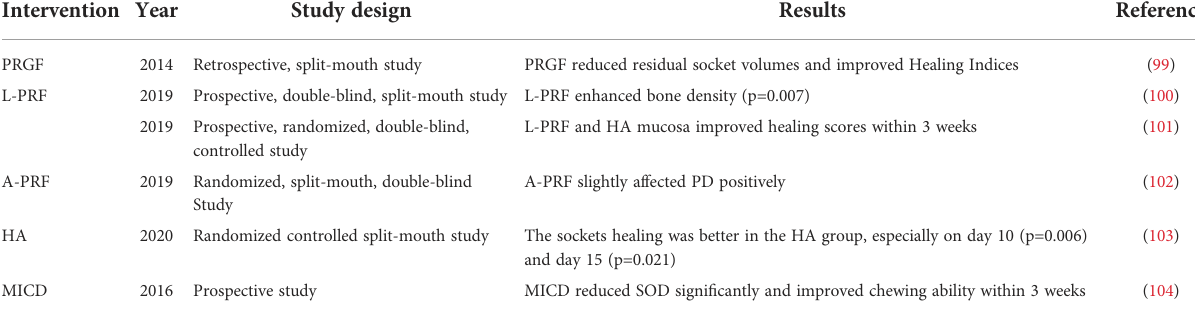
TABLE 1 List of clinical trials studies on extraction sockets healing in patients with diabetes. Intervention Year Study